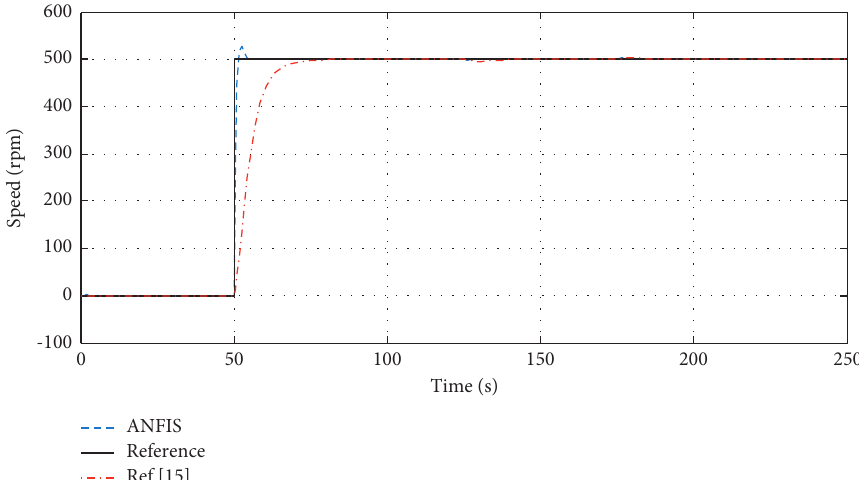
Figure 21: Comparison of our proposed method and reference [15] in the case of load apply at t � 125s and its removal at t � 175s.